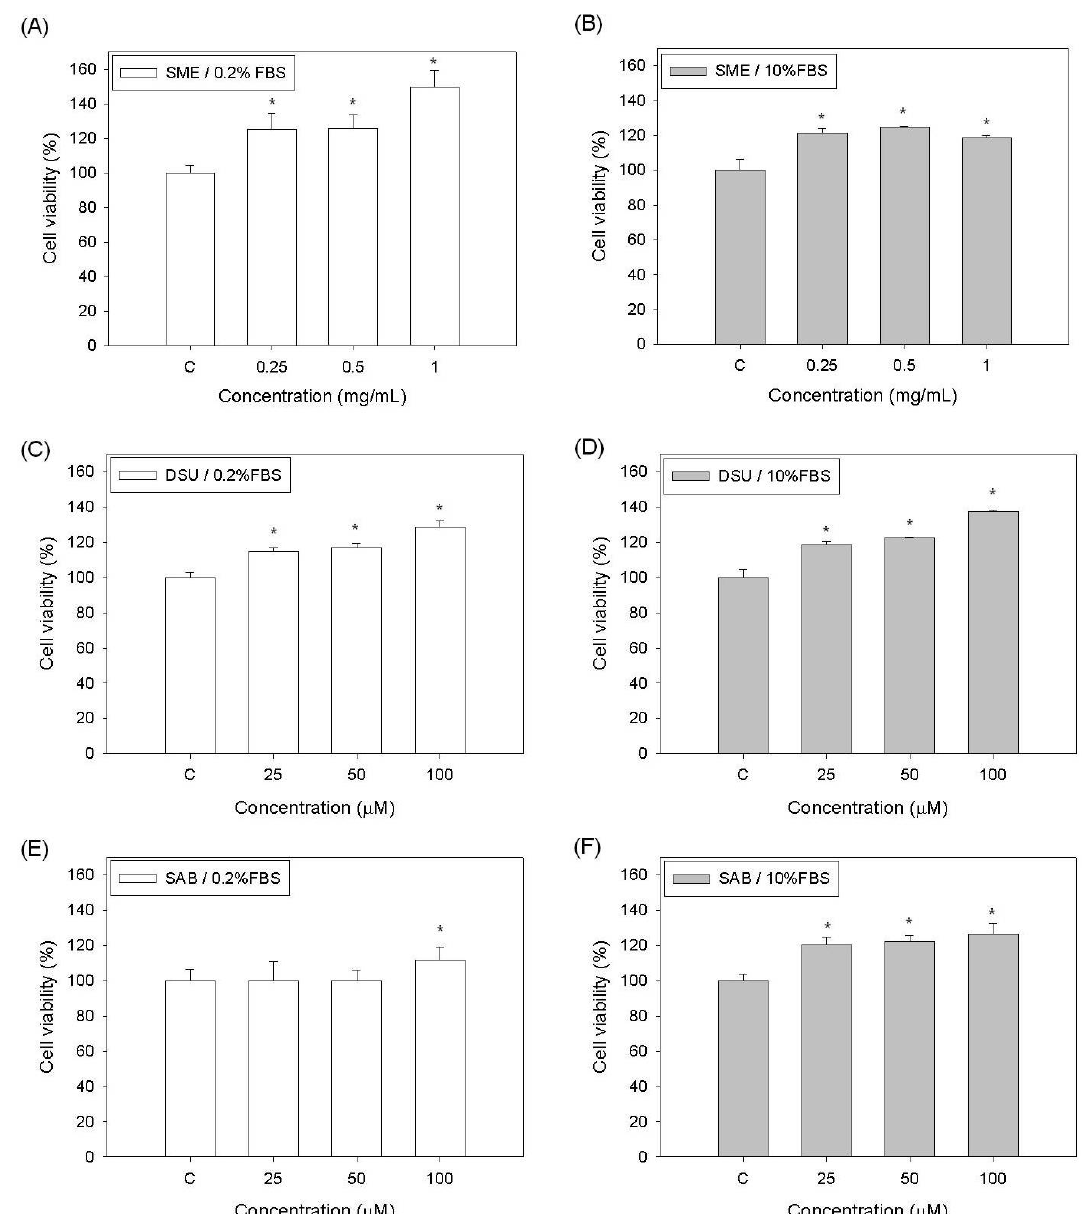
Figure 2. The effects of a S. miltiorrhiza extract (SME), danshensu (DSU) and salvianolic acid B (SAB) on the cell proliferation of Detroit 551 cells: ( A ) SME in 0.2% FBS; ( B ) SME in 10% FBS; ( C ) DSU in 0.2% FBS; and ( D ) DSU in 10% FBS; ( E ) SAB in 0.2% FBS, and ( F ) SAB in 10% FBS. Each value represents the mean ± SE ( n = 3). * p < 0.05, compared with the